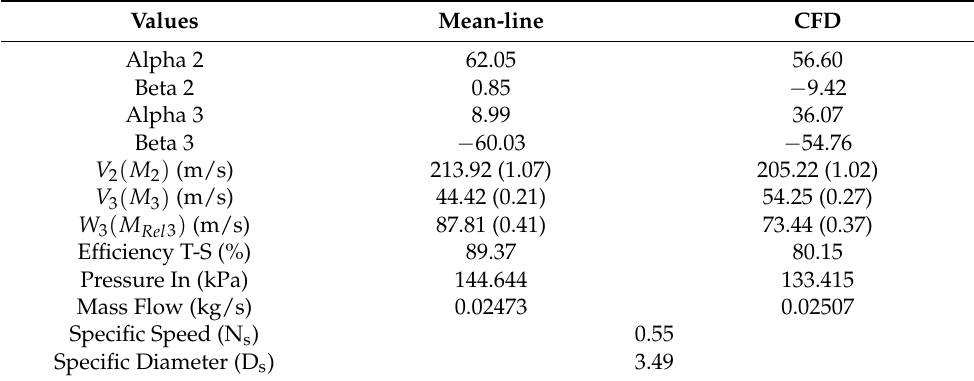
Table 7. Mean-line and CFD flow characteristics for the optimized turbine.